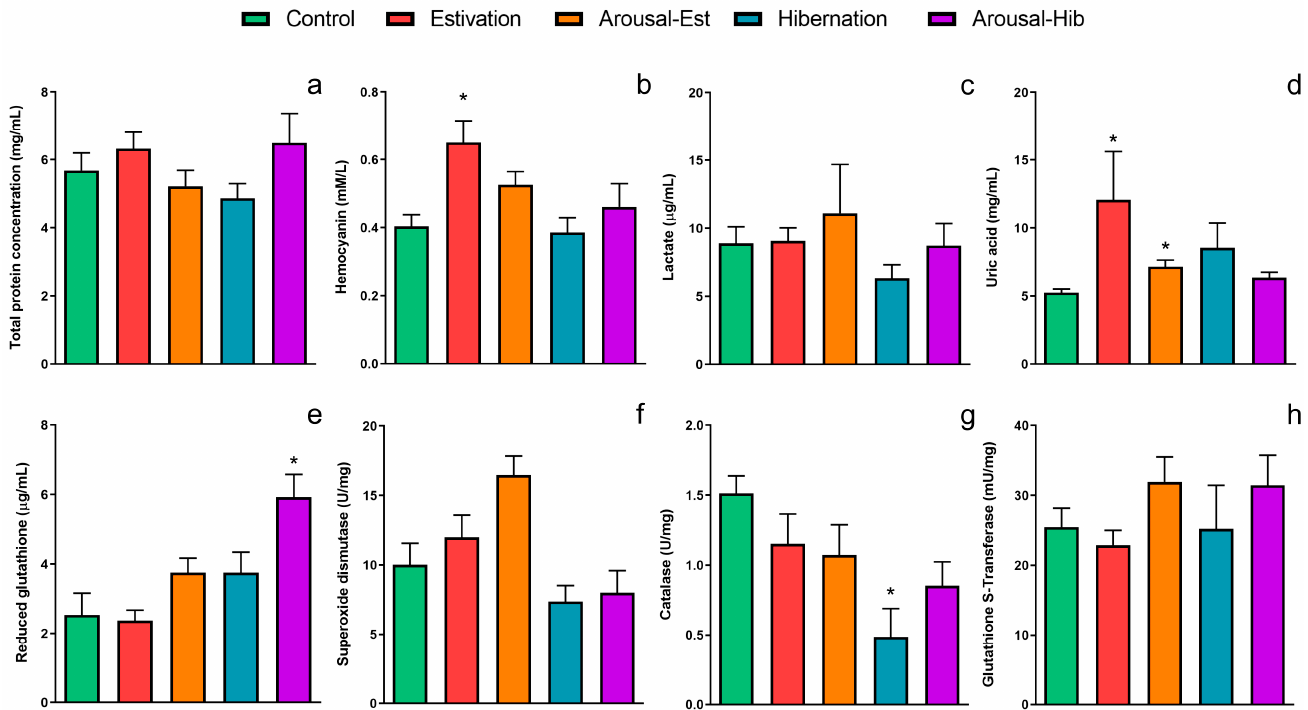
Figure 1. Biochemical compounds and antioxidant enzymes in the blood of P. canaliculata during activity–dormancy–arousal cycles. ( a ) Total protein concentration; ( b ) hemocyanin; ( c ) lactate; ( d ) uric acid; ( e ) reduced glutathione; ( f ) superoxide dismutase; ( g ) catalase; and ( h ) glutathione S-transferase activity. Mean ± SEM. Asterisks (*) indicate significant differences with the control group ( p < 0.05, Kruskal-Wallis, Dunn’s test). Table 1. Concentrations of proteins (mg/mL), hemocyanin (mM/L), lactate (µg/mL), uric acid (mg/mL), reduced glutathione (µg/mL) and enzyme activity of superoxide dismutase (SOD) (U/mg), catalase (CAT) (U/mg) and glutathione S-transferase (GST) (mU/mg) in hemolymph of animals exposed to activity–dormancy–arousal cycles.